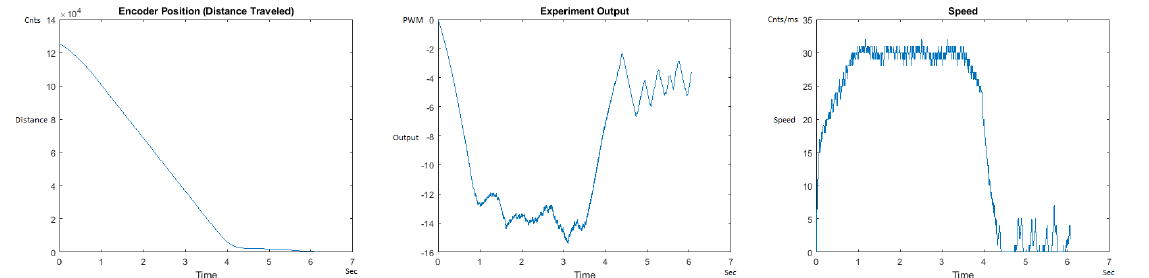
Figure 26. Encoder position, output and speed plots for PID++ DOWN operation— Vmax 30 cnts/ms, Adesired 0.040 cnts/ms 2 —1 Kg.